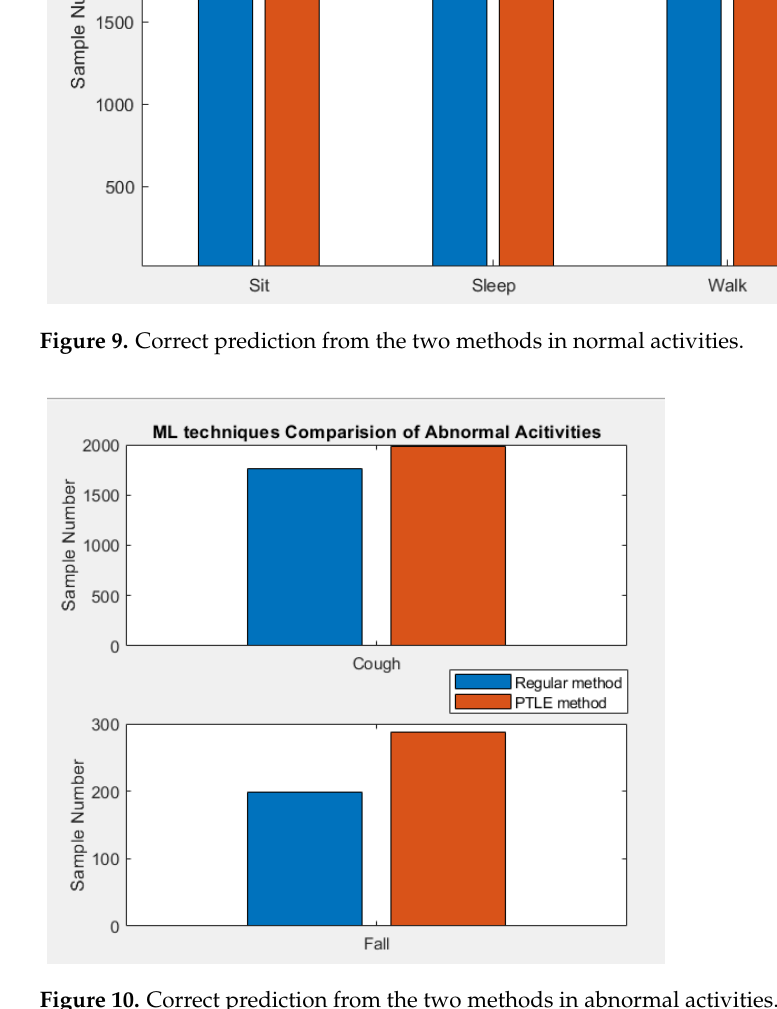
Table 5. Correct prediction comparison metrics.